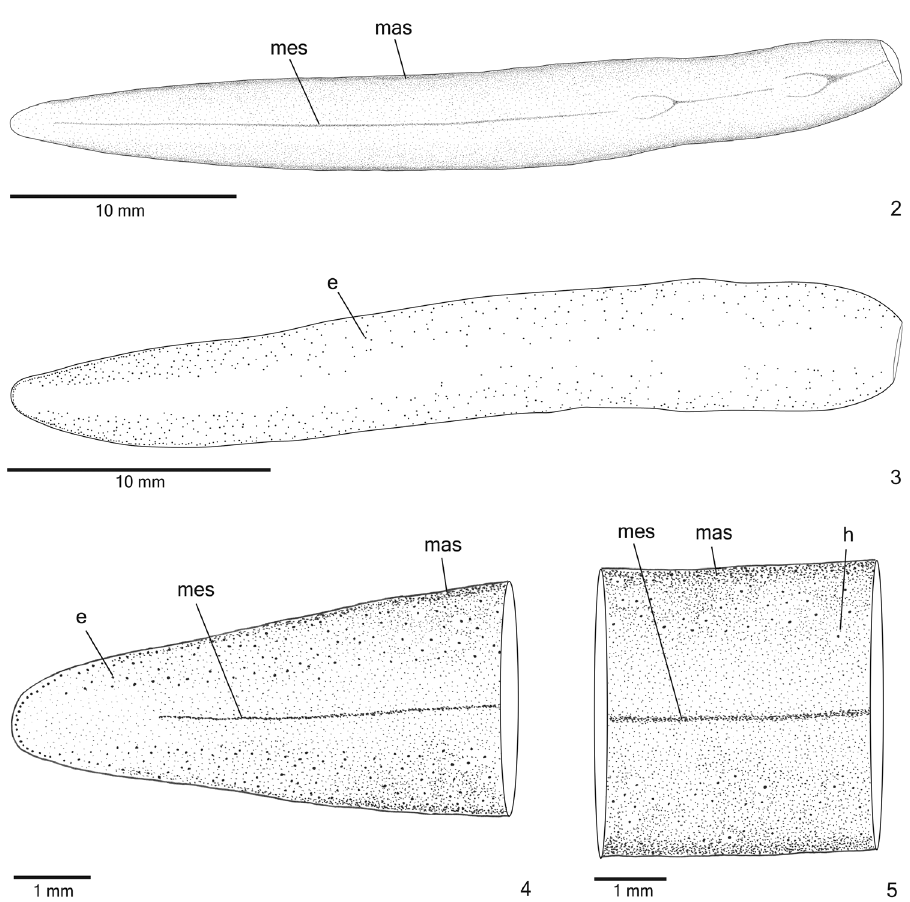
Figures 2–5. Cratera cryptolineata sp. n., dorsal view, 2 holotype, pattern of pigmentation 3 specimen